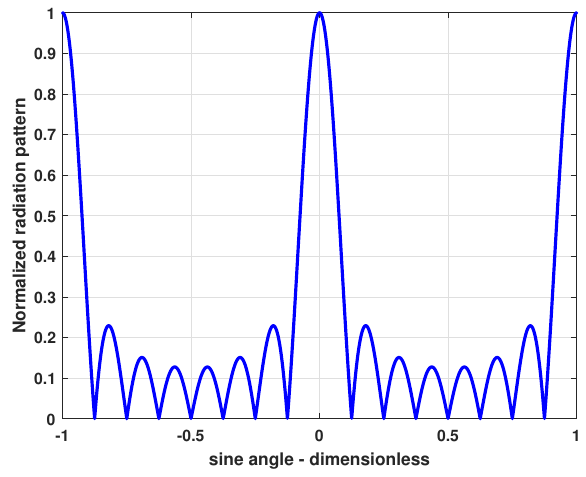
Figure 4. Radiation pattern for the linear array in Table